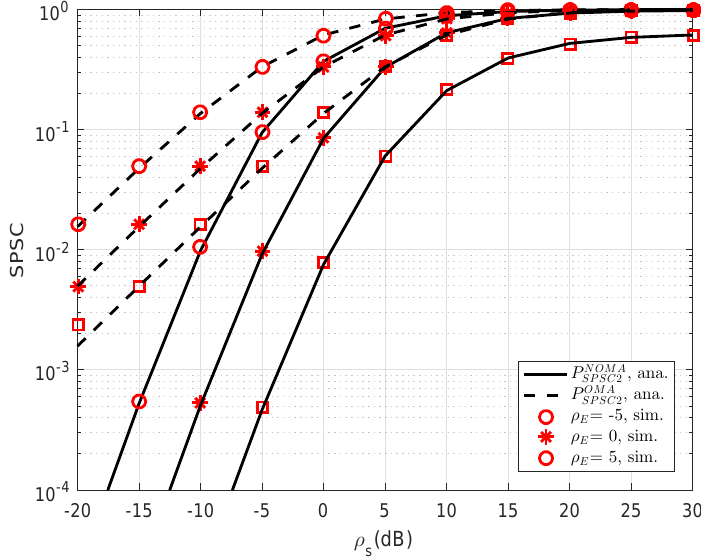
Figure 11. SPSC performance in several cases versus ρ S = ρ R as different choices of ρ E ( λ D 1 = λ D 12 = λ SRk = λ kD 2 = λ E = 1, K = 1, R 1 = 0.5, R 2 =